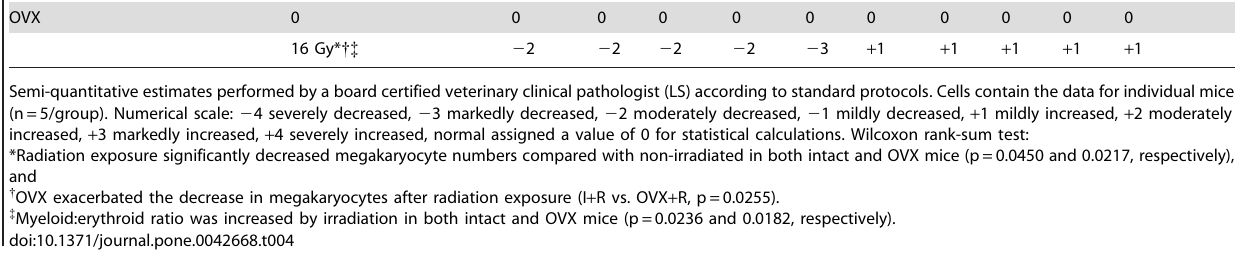
Treatment group